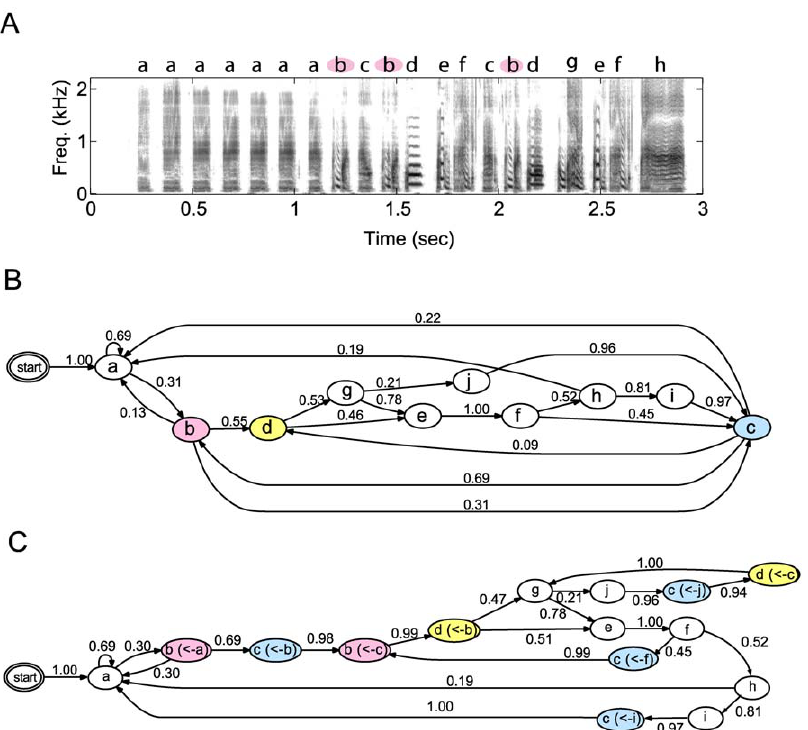
Figure 1. Example of sonogram of Bengalese finch song and its syllable label sequence. (A) Sonogram of Bengalese finch (BF09) with syllable labels annotated by three human experts. Labeling was done based on visual inspection of sonogram and syllables with similar spectrogram given same syllable. (B) Bigram automaton representation (transition diagram) of syllable sequences obtained from same song set as (A). Ellipses represent one syllable and arrows with values represent transitional probabilities. Rare transitions with probabilities v 0 : 01 are omitted. (C) POMM representation of same sequences as (B). Syllables that have significant higher-order dependency on preceding syllables (colored states in (B)) are divided into distinct states depending on preceding syllables (context).